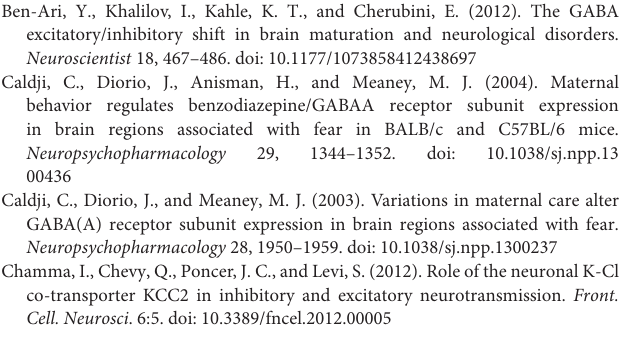
FIGURE S1 | Performance of qPCR primers using the RT-PCR methods. Representative gel electrophoresis image of mRNA transcripts for various GABA A R subunits, demonstrating the performance of qPCR primers using the RT-PCR method, on homogenates from the whole brain (Br), stomach (St), lung (Lu), bladder (Bl), kidney (Ki), heart (Hr), and liver (Li) obtained from adult male C57BL/6